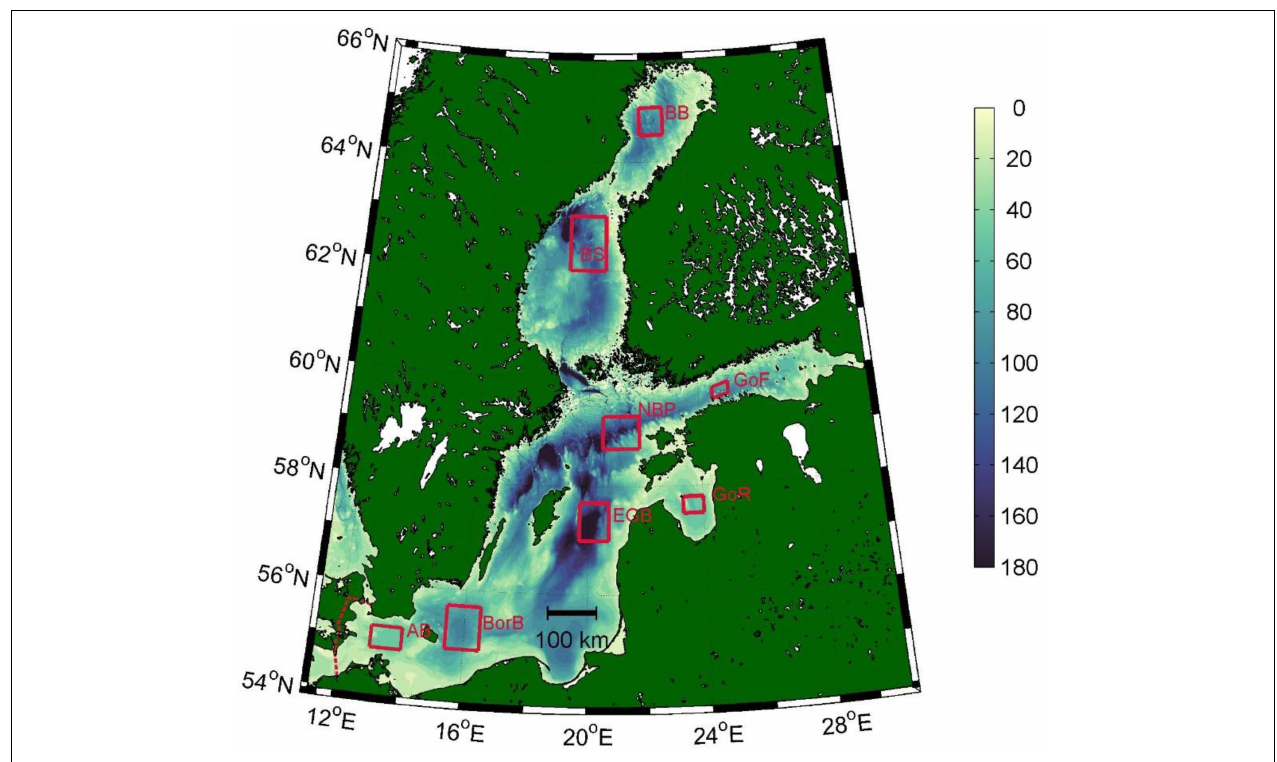
FIGURE 1 | Bathymetric map of the Baltic Sea with eight selected areas (red polygons) and the western edge of the study area (red dashed line). Color scale shows sea depths.